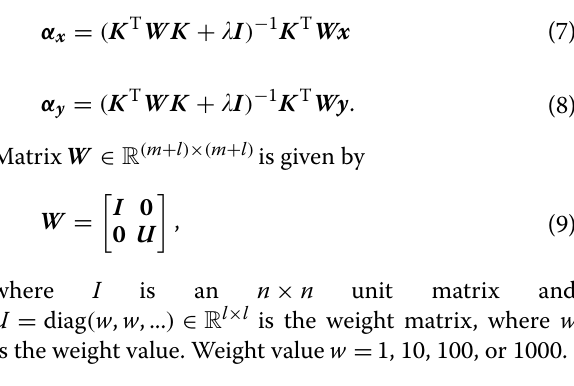
Personalized model: touch localization with the model constructed using samples from one